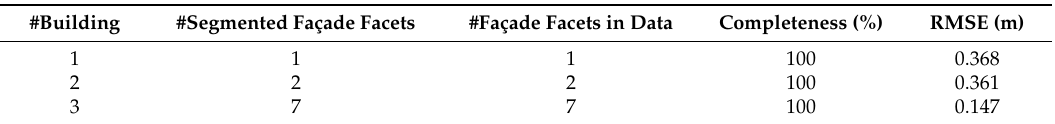
Table 5. Completeness and accuracy of facade segmentation.